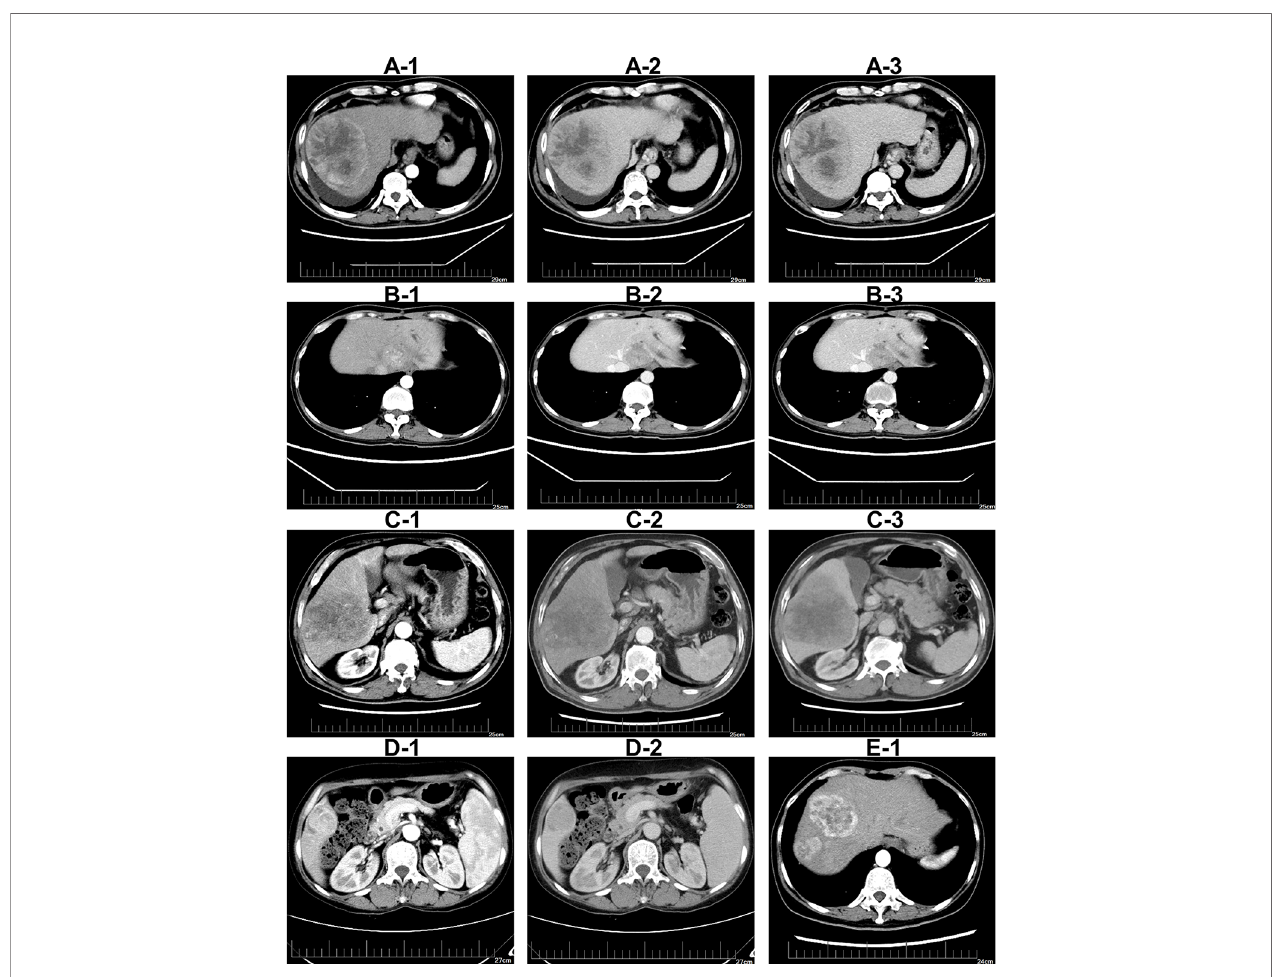
FIGURE 2 | Illustrations of imaging features on contrast-enhanced CT imaging (A-1 – A-3) . Tumor with peritumoral enhancement in arterial-phase, portal-phase, and late-phase (B-1 – B-3) .Tumor with intratumoral artery in arterial-phase, portal-phase, and late-phase (C-1 – C-3) .Tumor with irregular shape in arterial-phase, portal- phase and late-phase (D-1, D-2) . Tumor with unclear boundary in contrast-enhanced CT imaging. Tumor with multiple nodules in CT imaging (E-1)